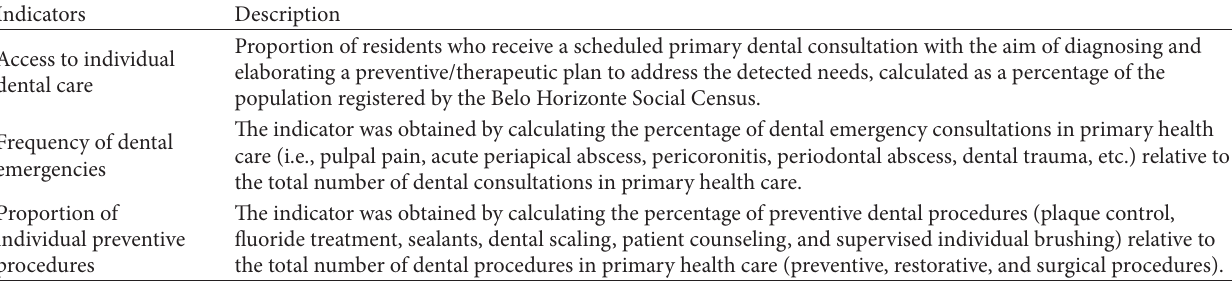
Table 1: Indicators used for cluster formation, Belo Horizonte, 2010.